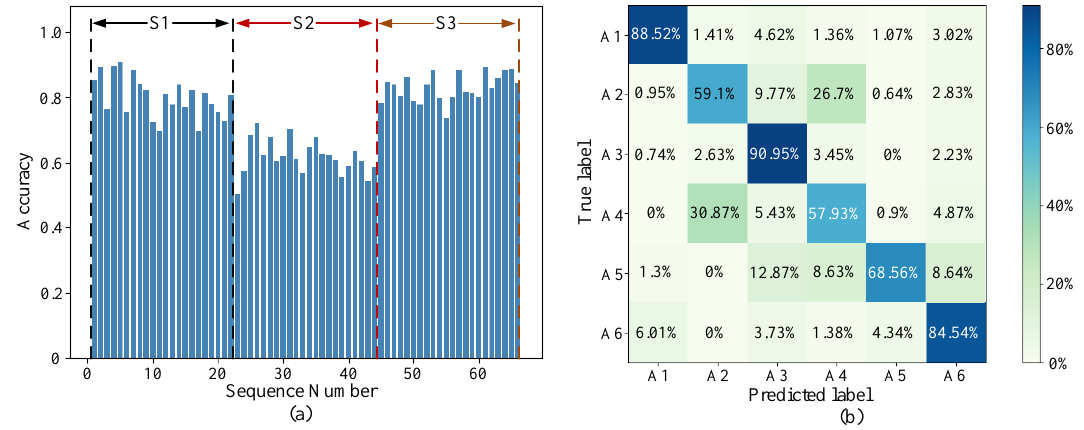
Figure 11. ( a ) Recognition performance; ( b ) confusion matrix of Uni-LSTM sub-network at 1.7 GHz spectrogram.